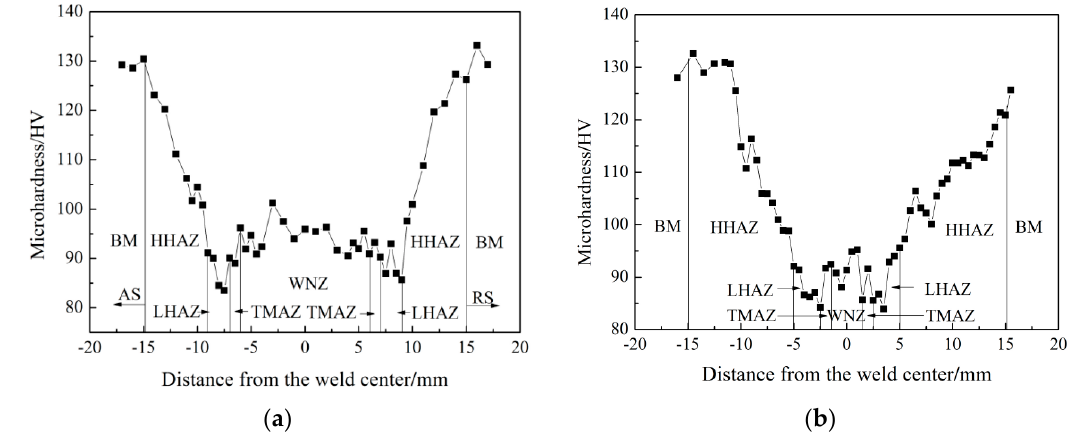
Figure 4. Hardness distributions of ( a ) upper and ( b ) lower surfaces in the joint.